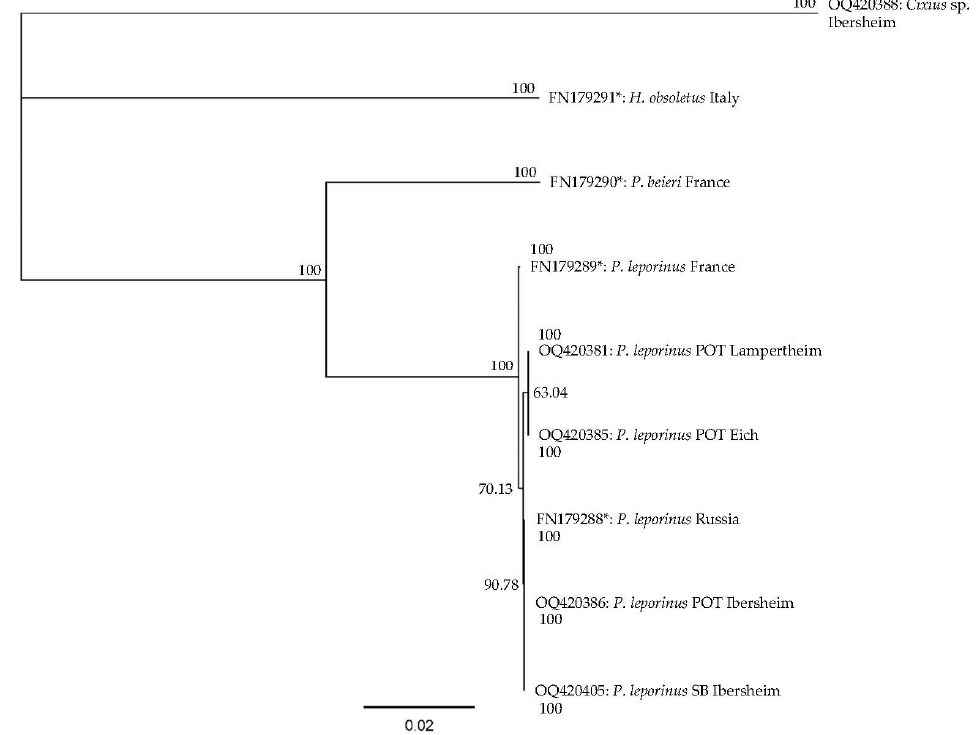
Figure 2. Phylogenetic relationship between cytochrome oxidase subunits I and II (COI and COII) sequences from collected Pentastiridius leporinus , Hyalesthes obsoletus, and Cixius sp. Specimens, and sequences of planthoppers from earlier studies (marked with *) [8]. The tree was constructed using the neighbor-joining method, based on a MUSCLE alignment of COI and COII sequences. The bar indicates the number of substitutions per site. Bootstrap values (10,000 replications) are included as numbers at the branches. POT: found in potato, SB: found in sugar beet. Based on COI and COII sequences, the planthoppers found in potato and sugar beet showed a closer genetic relationship to P. leporinus than the two known references from France and Russia. The nearest related species ( P. beieri ), as well as the more distantly related H. obsoletus and Cixius sp. specimens, showed clear sequence